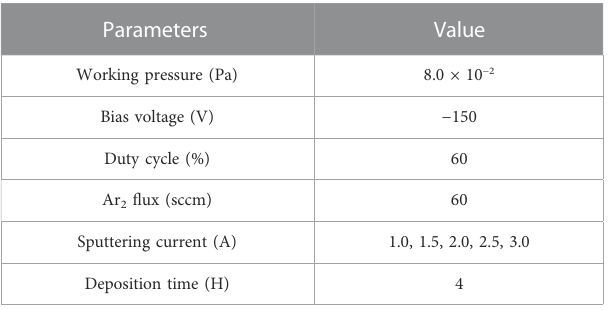
TABLE 1 Depositing parameters for the amorphous carbon fi